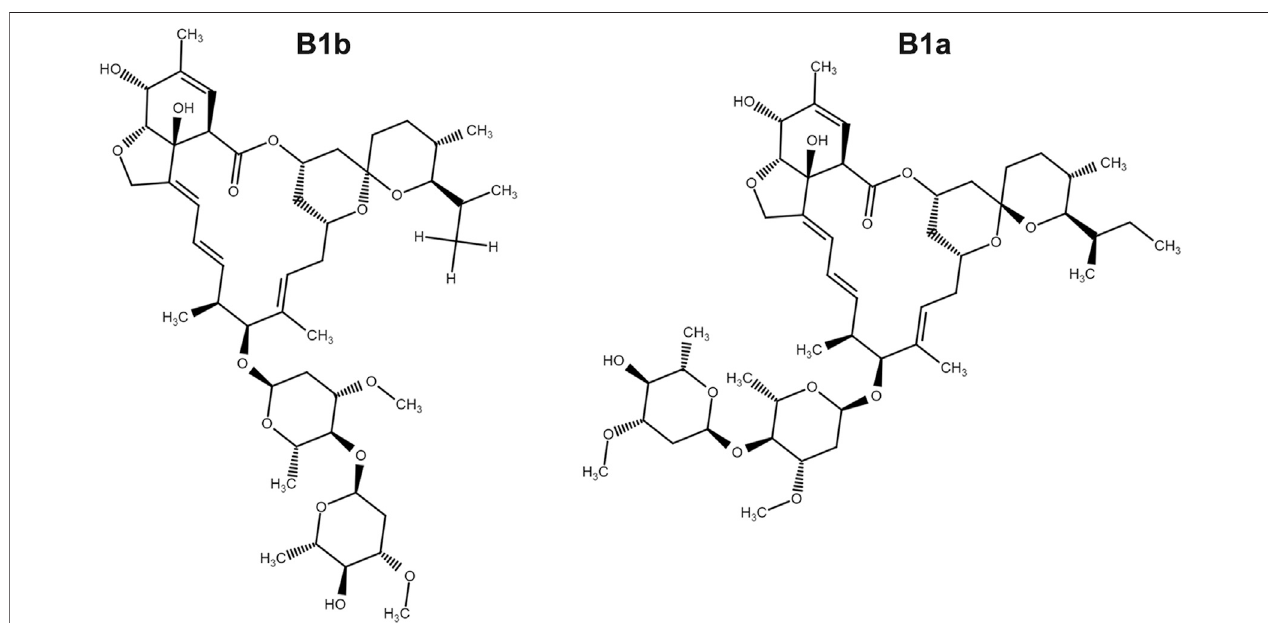
FIGURE 1 | The chemical structure of ivermectin which is composed of ivermectin B1a ( > 90%) and ivermectin B1b.